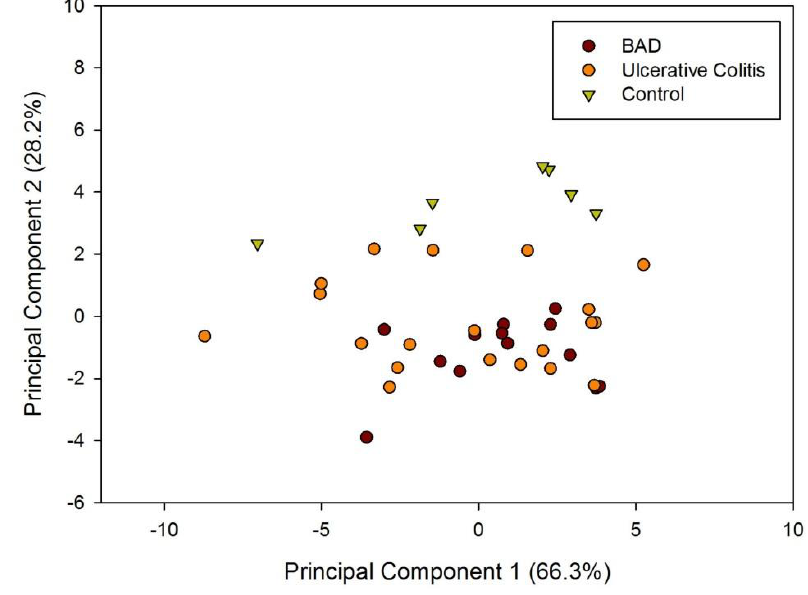
Figure 2. Principal Component Analysis of AlphaMOS Fox 4000 results.